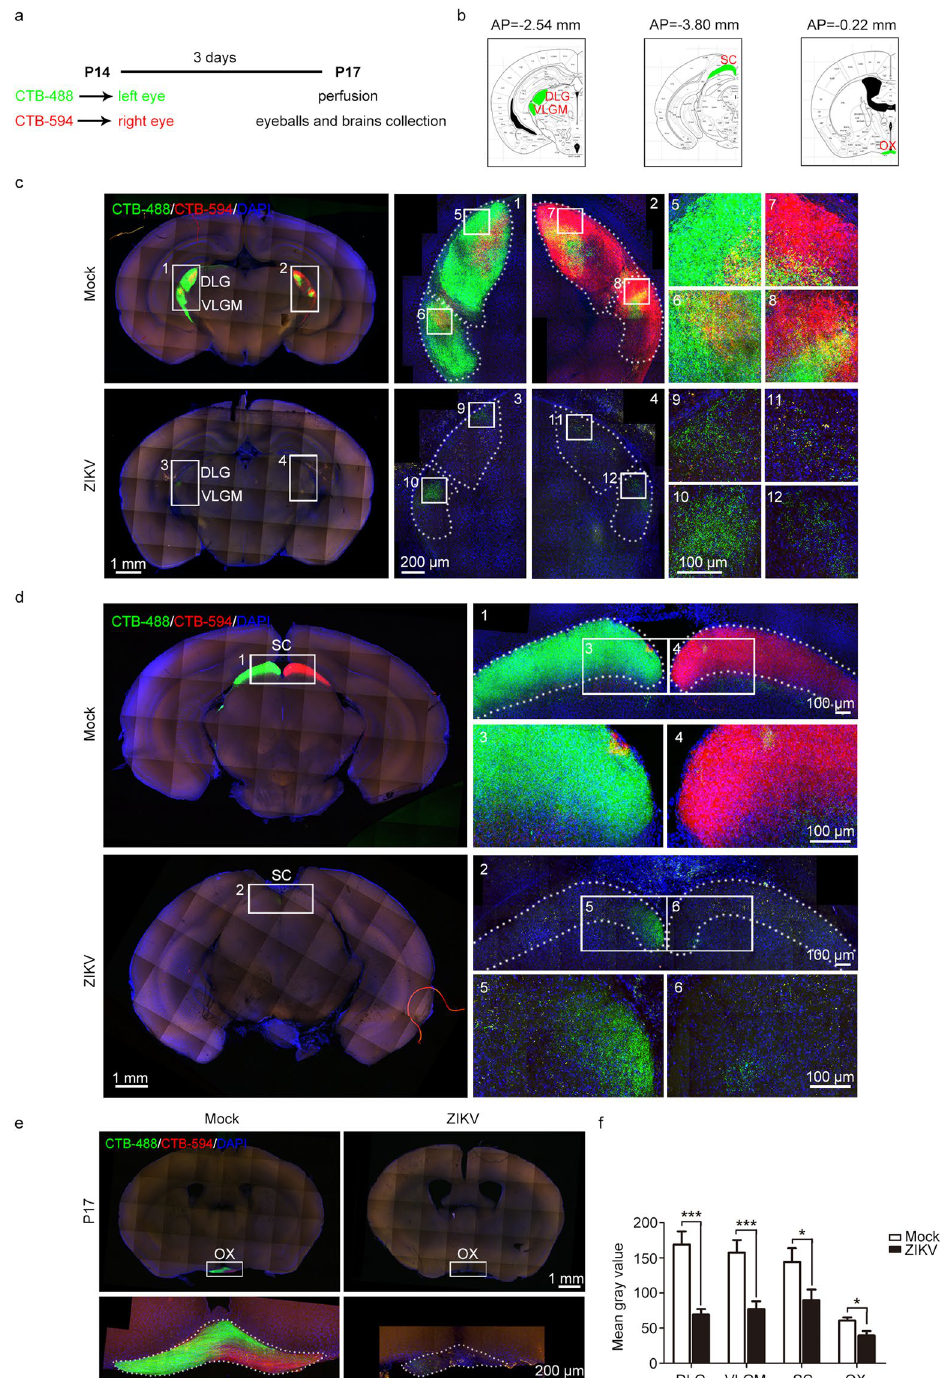
Figure 4. Impaired visual projection was induced by maternal ZIKV infection. (a) Schematic depiction of the anterograde tracing method used. (b) Brain atlases indicate the sites of brain slices in (c), (d), and (e), respectively. (c – e) Results of visual projection in the LGN (c), SC (d), and OX (e), respectively. (f) Mean gray value of visual projection fibers in the DLG, VLGM, SC, and OX. DLG and VLGM: n Mock = 10, n ZIKV = 14 samples; SC: n Mock = 11, n ZIKV = 10 samples; OX: n Mock = 11, n ZIKV = 9 samples from three independent experiments. Data are presented as the mean ± SEM. Student’s t -test, * p < 0.05, *** p <